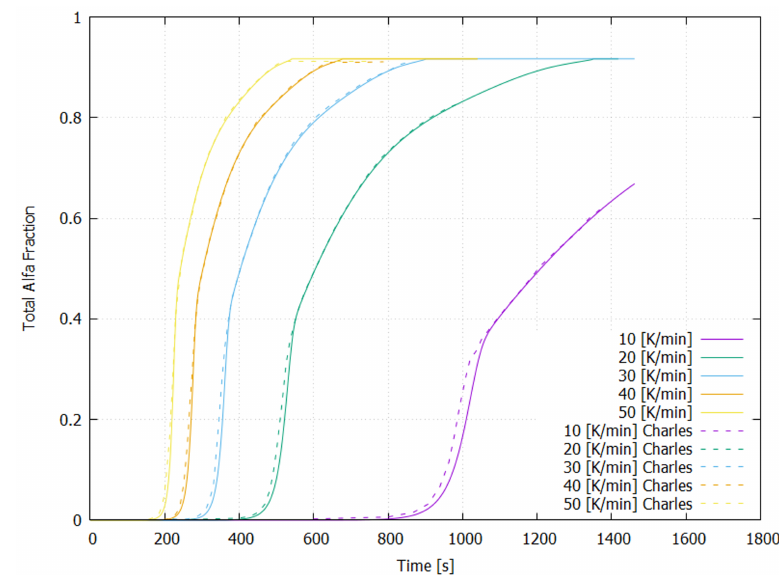
Figure 6. Alpha phase evolution calculated for different cooling rates. Comparison with numerical Figure 6: Alpha phase evolution calculated for di⁄erent cooling rates. Comparison with numerical results from Charles et al. model [7] (same TTT material input). results from Charles et al. model [10] (same TTT material input).